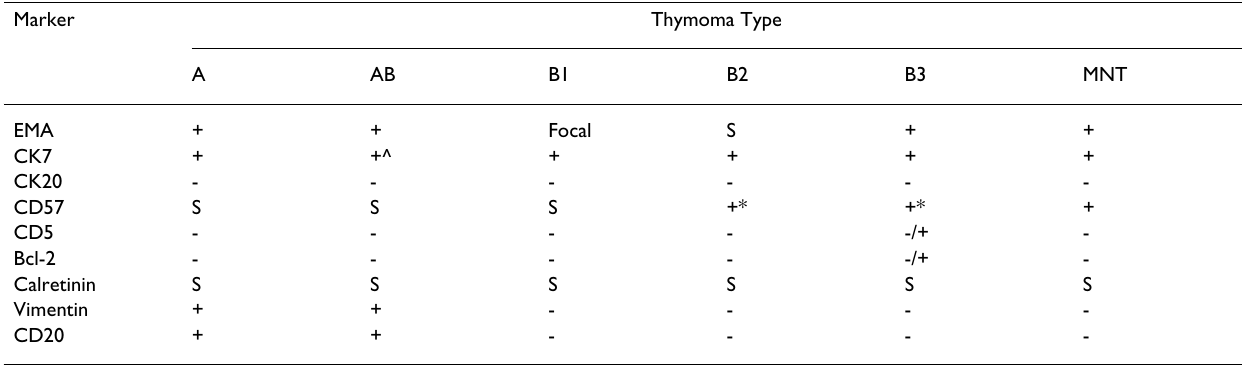
Table 3: Immunohistochemical Results, Tumor Cell Expression